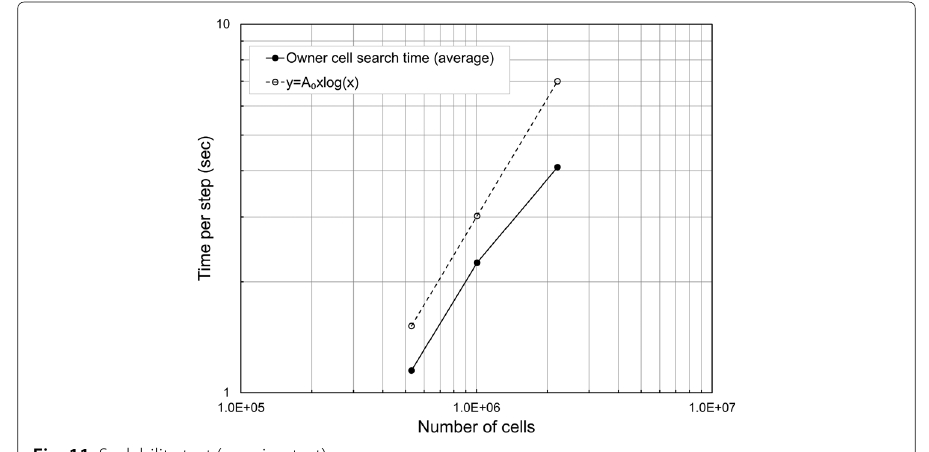
Fig. 11 Scalability test (crossing test)